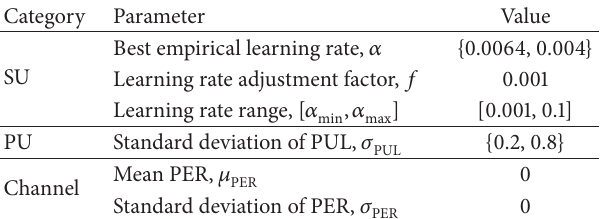
Table 6: Simulation parameters and values for investigating the learning rate adjustment